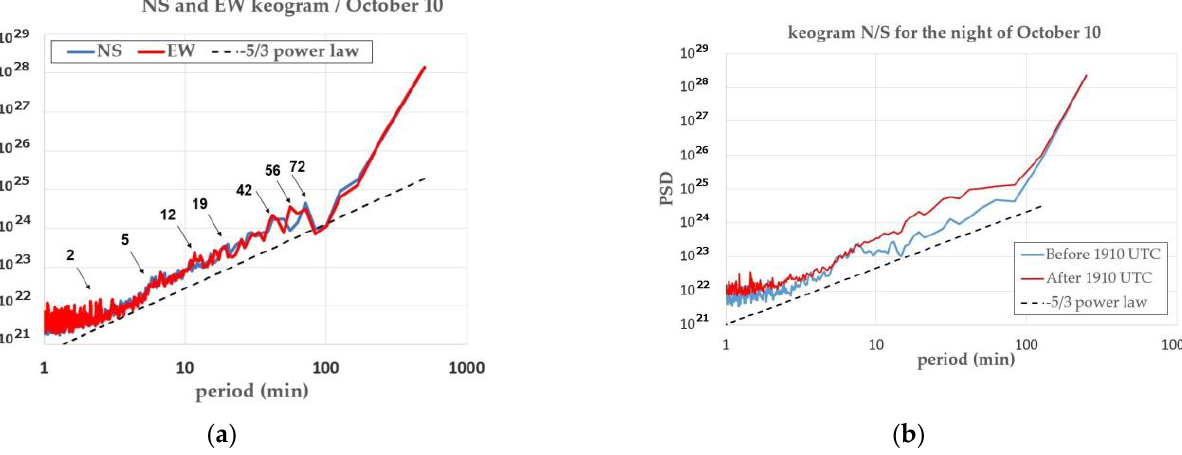
Figure 24. ( a ) Power spectral density (PSD) of the N/S (blue) and W/E (red) keograms for the night of 10 October. The black dashed line shows the −5/3 power law; ( b ) Periodogram for the N/S keogram for the shortest wavenumbers.